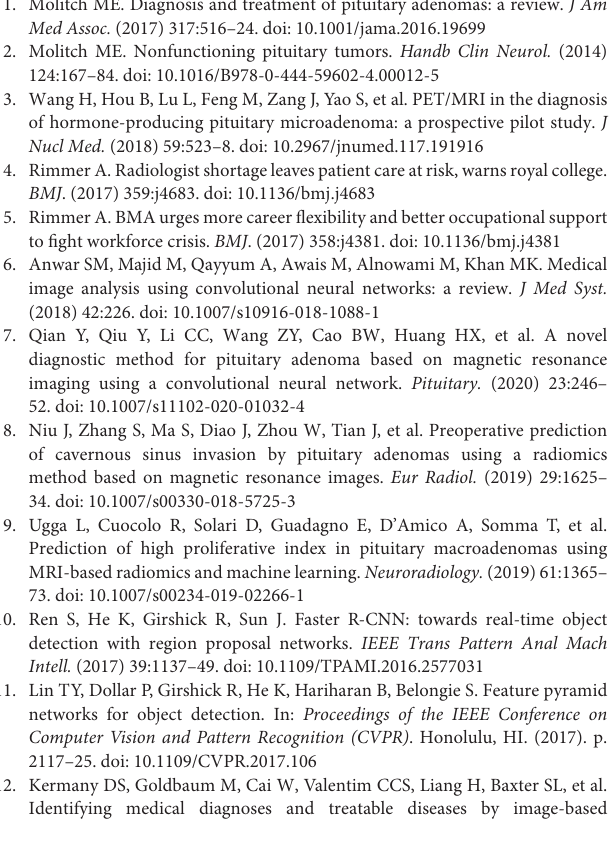
general radiologists (no specialization). Workload analysis was performed on the participating radiologists for 1 year. Supplementary Table 2 | Confusion Matrices for testing and validation of dataset A (internal and external datasets). Data are numbers of images. a, true-positive; b, false-positive; c, false-negative; d, true-negative. Supplementary Table 3 | The diagnostic performance for Human-computer competition according to temporal validation set B ( n = 100). Unless otherwise specified, data are percentages, with numbers of images in parentheses and 95% confidence intervals in brackets. F1 score, the harmonic mean of PPV and sensitivity. NPV, negative predictive value; PPV, positive predictive value. Radiologist 1 & 2, < 5 years professional experience; Radiologist 3 & 4, 5 - 10 years professional experience; Radiologist 5 & 6, > 10 years professional experience. Supplementary Table 4 | Confusion Matrices for Human-computer competition according to temporal validation set B ( n = 100). Data are numbers of images. a, true-positive; b, false-positive; c, false-negative; d, true-negative.